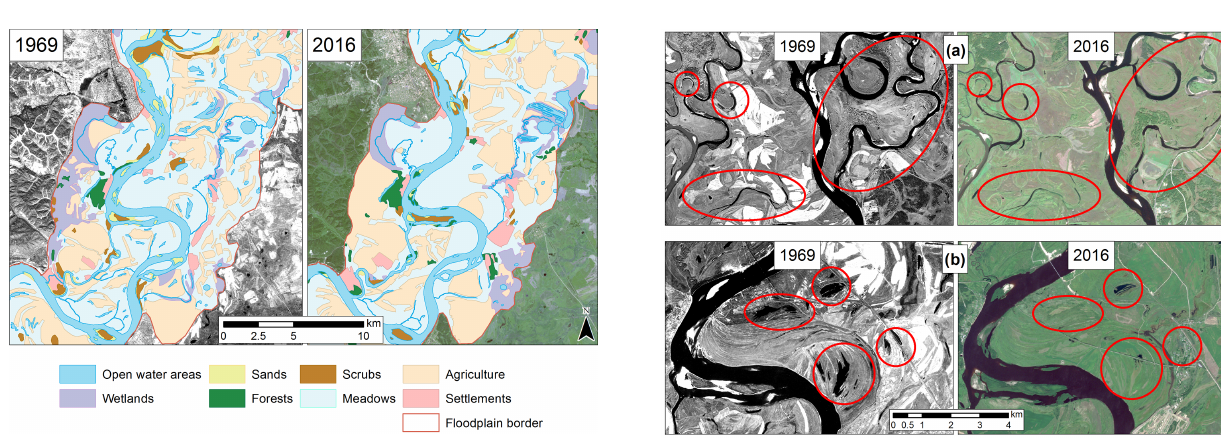
Figure 5. Examples of the changes in the floodplain objects. Red circles mark the differences detected for water bodies: (a) a river channel that has become a chain of oxbow lakes; the surface area of the lakes has been reduced in the Floodplain Section 1; (b) the sur- face area of the lakes has been reduced in the Floodplain Section